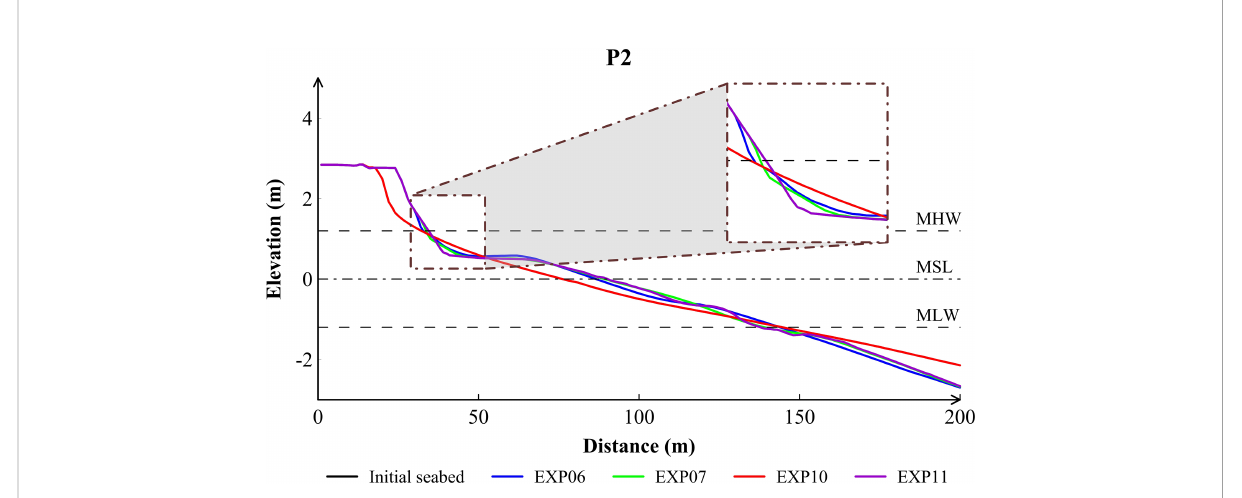
FIGURE 10 The elevation of P2 pro fi le changed under different wind conditions compared with initial seabed.